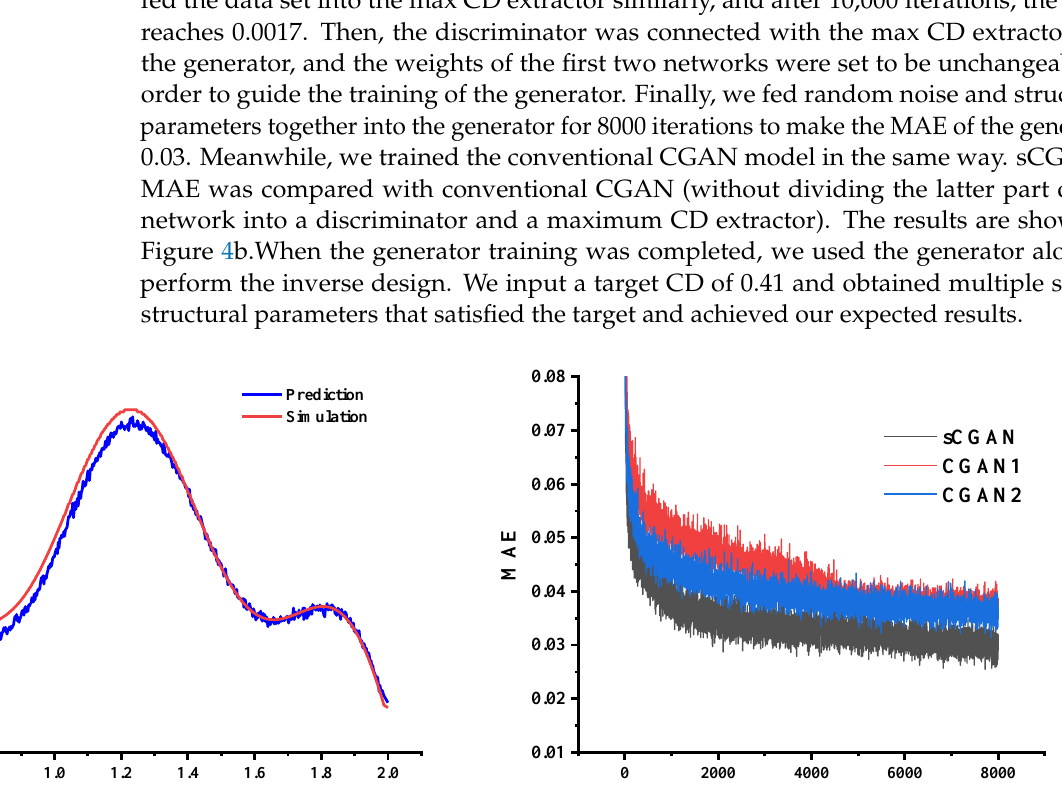
( b ) Figure 5. ( a ) Circular polarization transmission coefficient of H-type structure. ( b ) CD spectra of H type and m-H type. The trends of ellipticity and circular dichroism in the case of metasurface cell rotation are shown in Figure 6. It can be seen that the circular dichroism and ellipticity change as